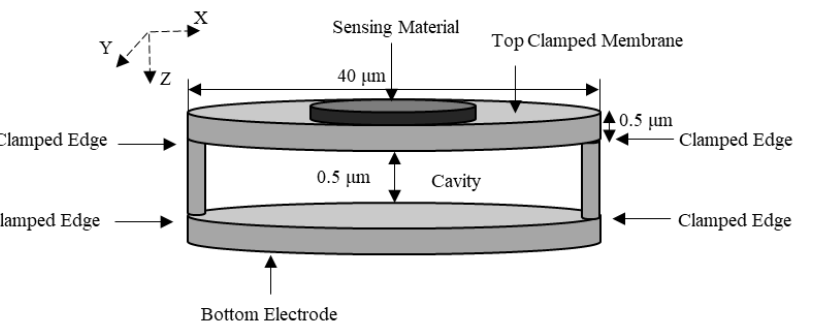
Figure 16. Schematic view of a capacitive clamped membrane structure ( x – z axis perspective) (image not to scale).